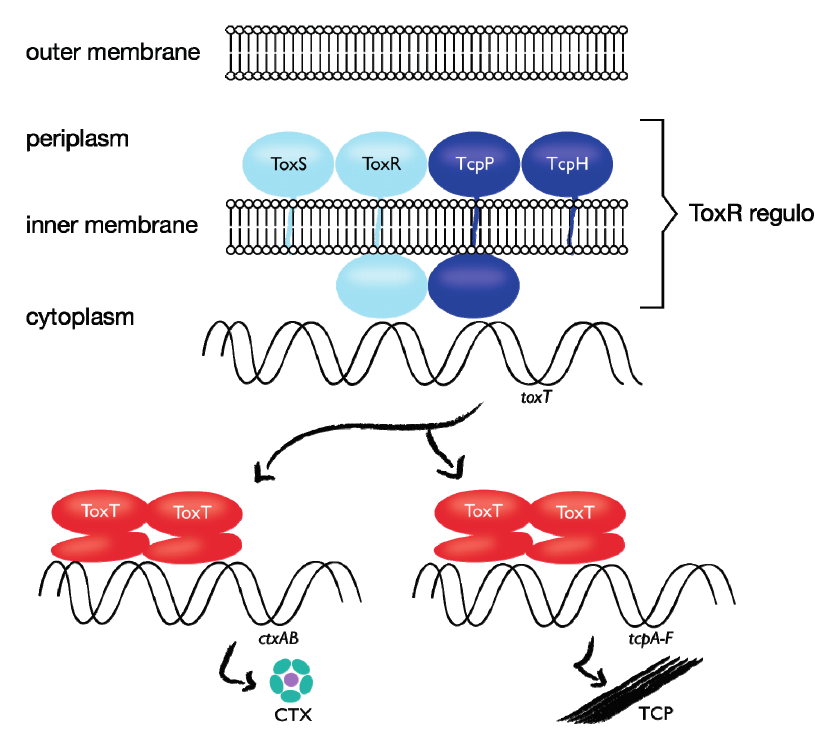
Figure 2. Role of the ToxR regulon in controlling cholera toxin (CTX) expression. The inner-membrane proteins TcpP and ToxR bind DNA at the toxT promoter, and activate transcription of toxT . ToxS and TcpH contribute to the function or stability of ToxR and TcpP, respectively. ToxT activates ctxAB and tcpA–F transcription. Figure modified from reference